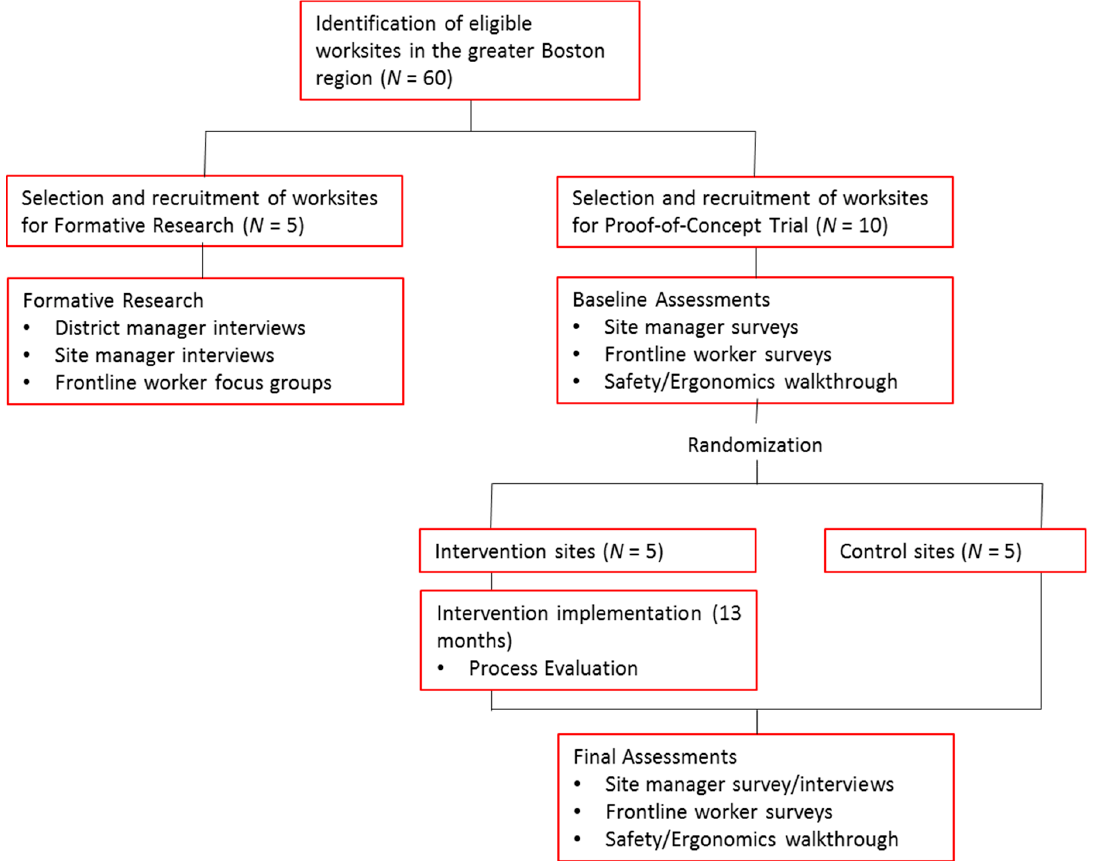
Figure 2. Study design, settings, and samples.